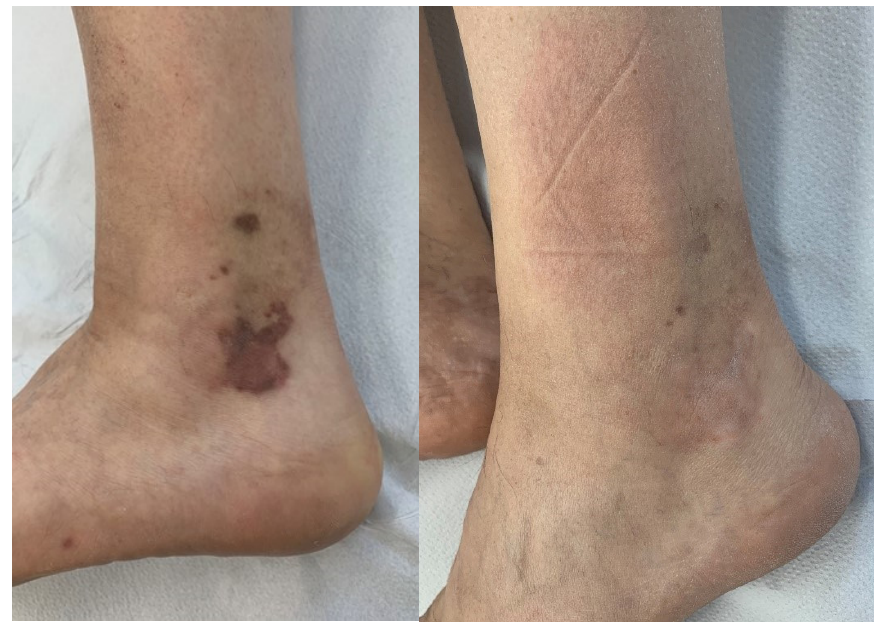
Figure 1. Patient with classic KS at T0 ( left ) and T5 ( right ).